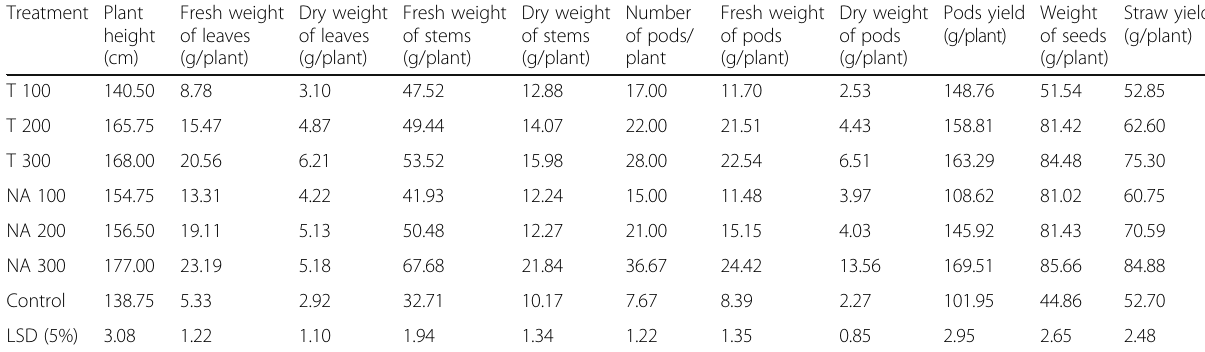
Table 3 Effect of tryptophan and nicotinamide on the yield of guar pods, seeds and straw Treatment Plant height